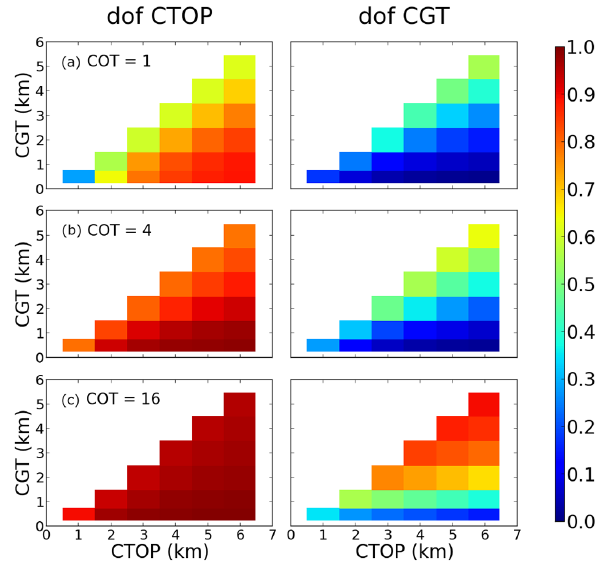
Figure 19. Same as Fig. 14 with an albedo of 0.2.